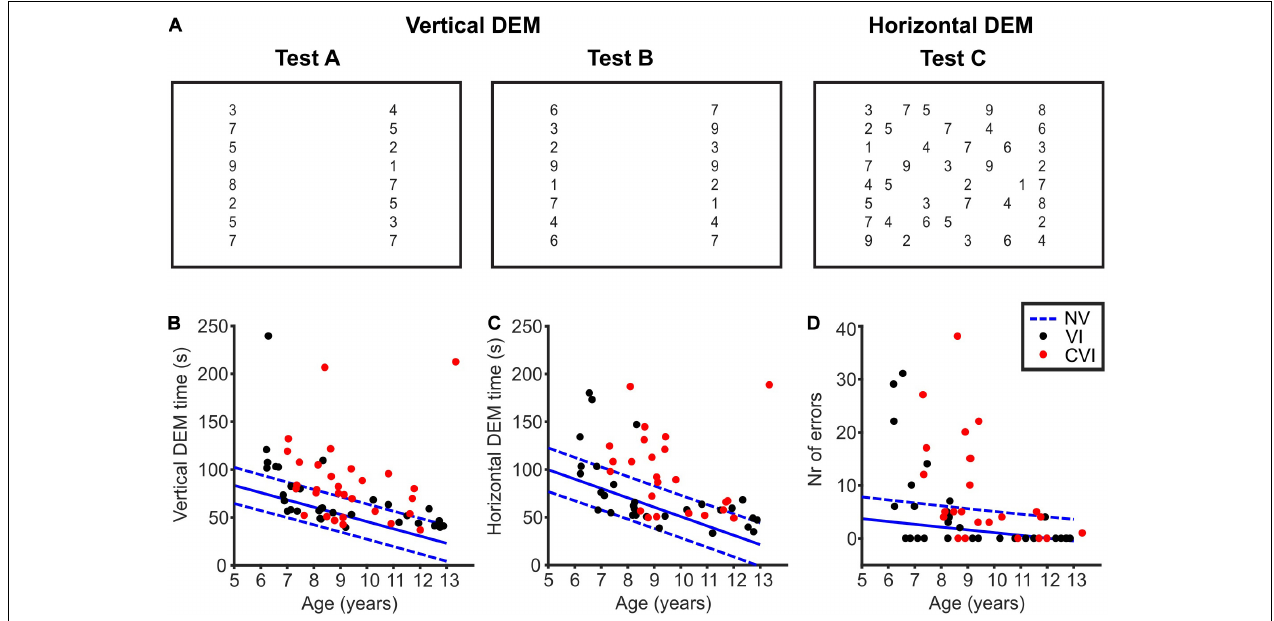
FIGURE 1 | The developmental eye movement test (DEM). (A) Overview of the DEM test. Numbers not drawn to scale. Adopted from Tanke et al. (2021). (B) Total time needed to read the numbers of the vertical DEM (test A + B) for children with VI (black dots) and CVI (red dots). In blue, the mean (solid line) vertical DEM times of NS children and the corresponding 90% prediction intervals indicated by the 5th and 95th percentile (dashed lines) of the duration distributions. (C) Same as for (B) , but for the error-adjusted horizontal DEM time (test C). (D) Same as for (B) , but for the number of errors made during the horizontal DEM.